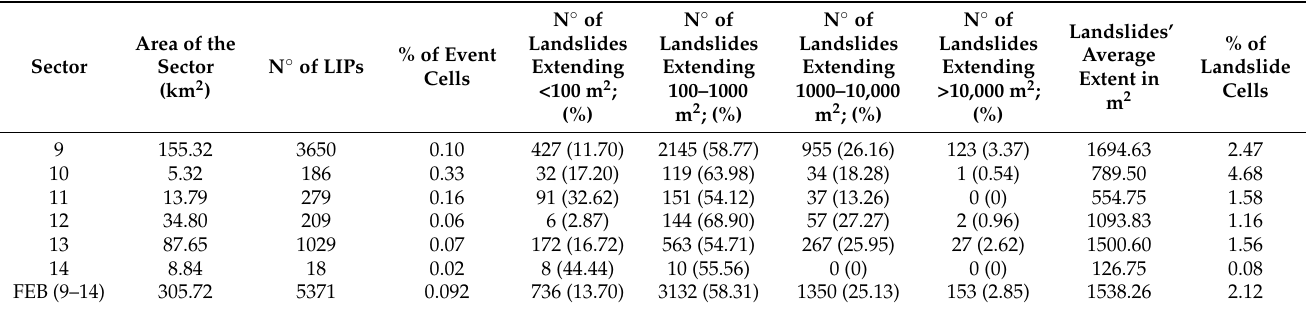
Table 7. Amounts and characteristics of the gravitational phenomena of landslides belonging to sectors 9 to 14, related to the February earthquake.